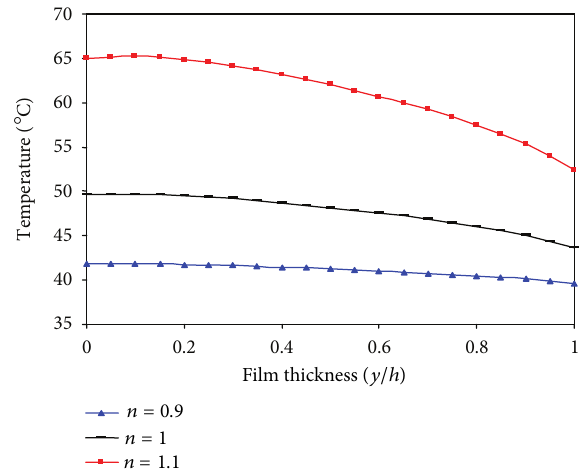
Figure 18: Film temperature variation versus the circumferential coordinate at the central plan of the journal bearing. Comparison between our results and those of